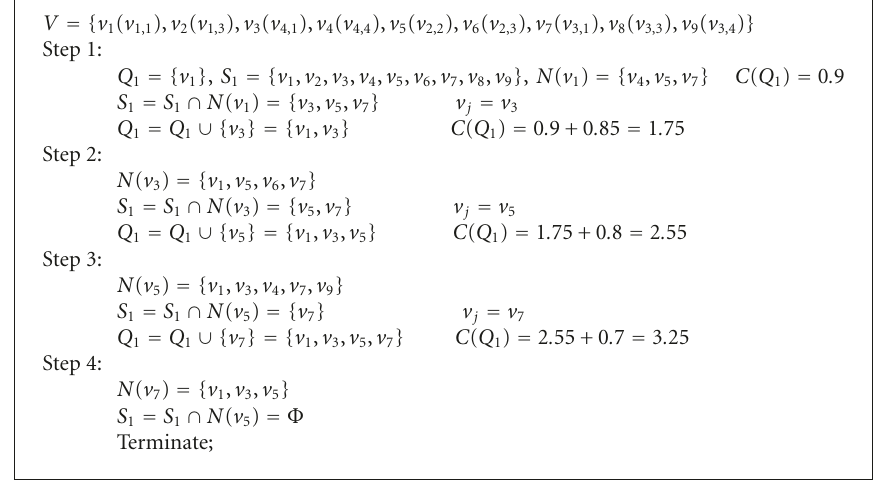
Algorithm 2: The steps of finding Q 1